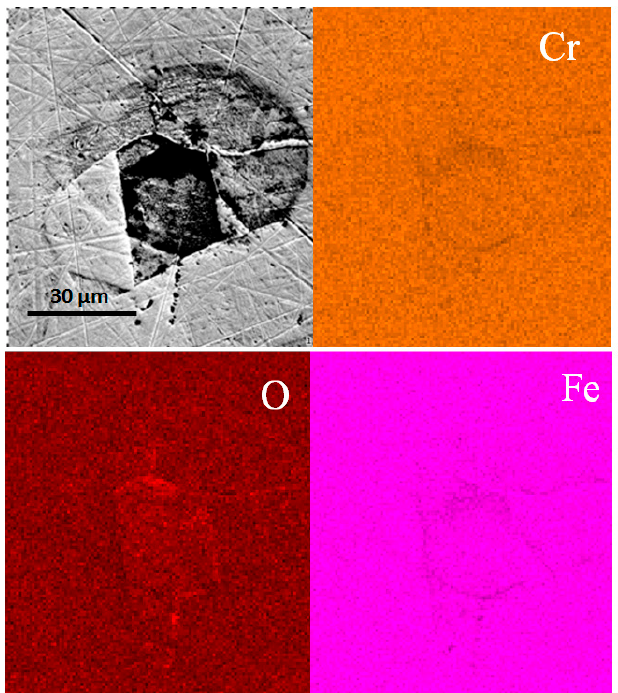
Figure 3. SEM morphologies and EDS mapping results of mechanically bonded 316L before